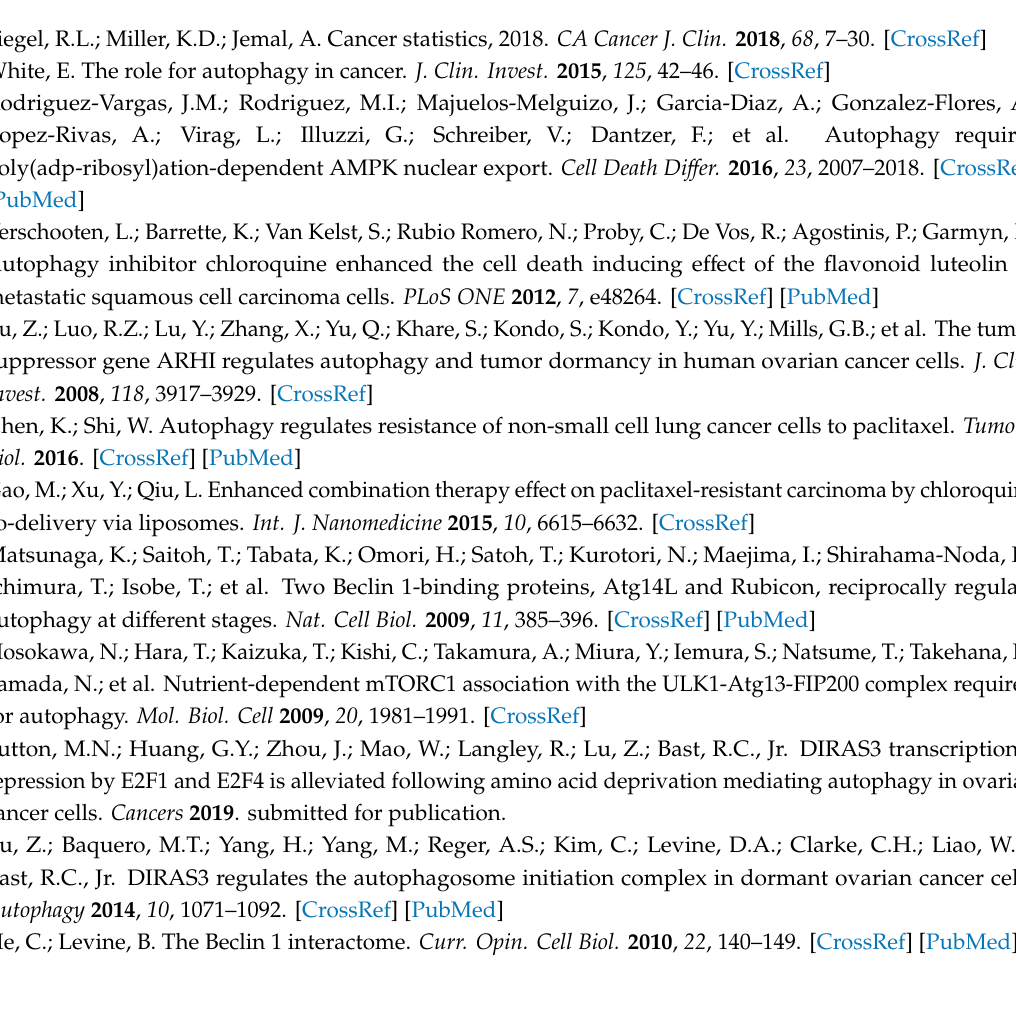
Figure S1: Liquid chromatogram of Tat-D3S2 peptide synthesis, Figure S2: Mass spectrometry of Tat-D3S2 peptide synthesis. Figure S3: Raw data films for western blot analysis shown in Figure